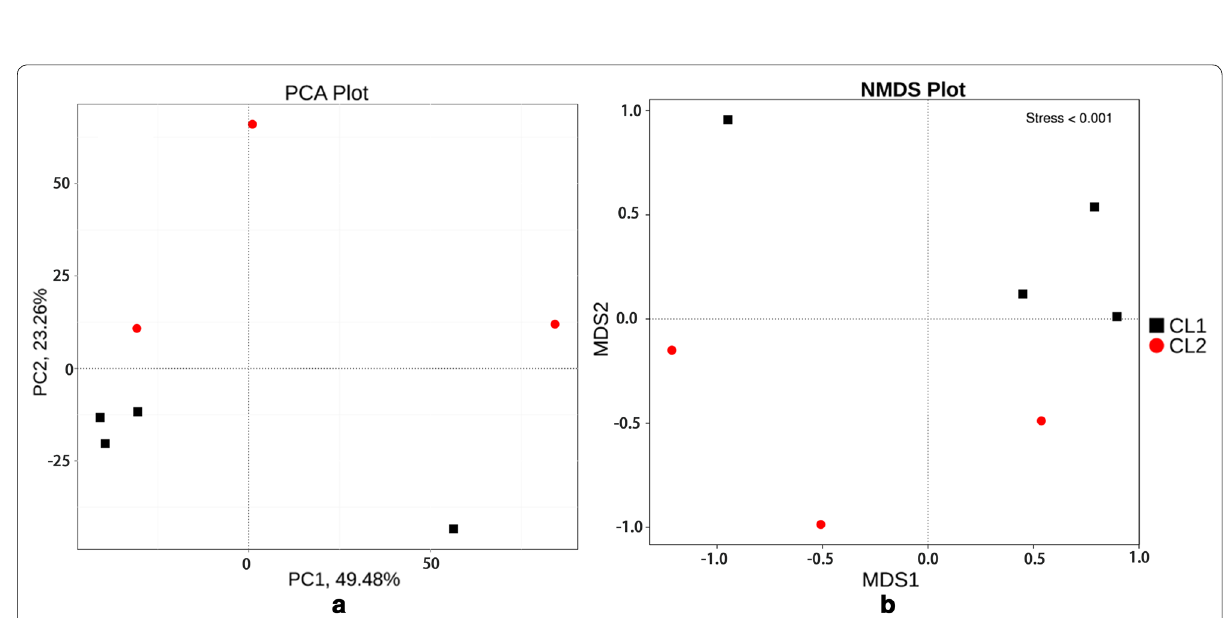
Fig. 5 The PCA and NMDS dimension reduction analysis based on the functional gene abundance using KEGG databases. a PCA analysis; b NMDS dimension reduction